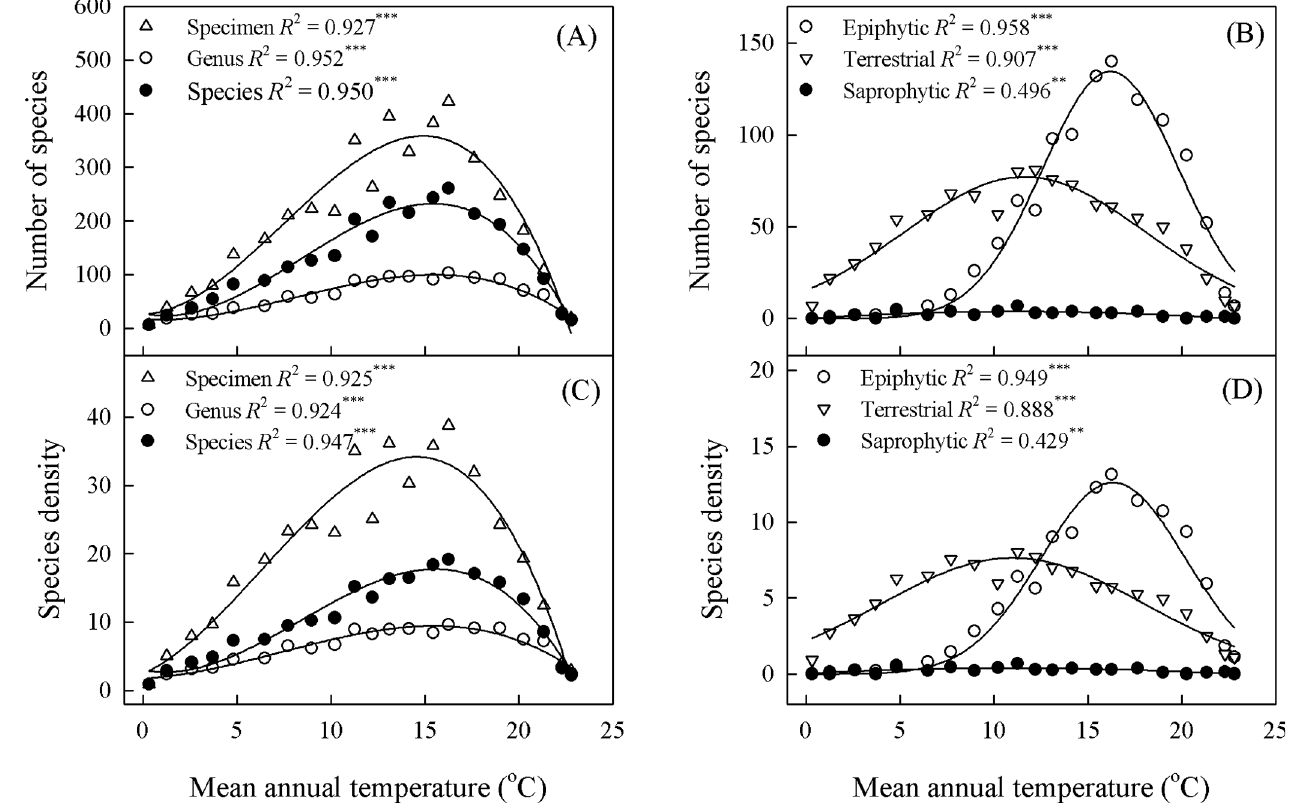
Fig 6. Variations in orchid species richness (SR, panel A-B) and species density (SD, panel C-D) as function of mean annual temperature (MAT). (A) Specimen: SR = 25.376 + 1.408 * MAT − 4.304 * MAT 2 − 0.194 * MAT 3 ; Genus: SR = 16.733 − 1.682 * MAT + 1.247 * MAT 2 − 0.051 * MAT 3 ; Species: SR = 28.621